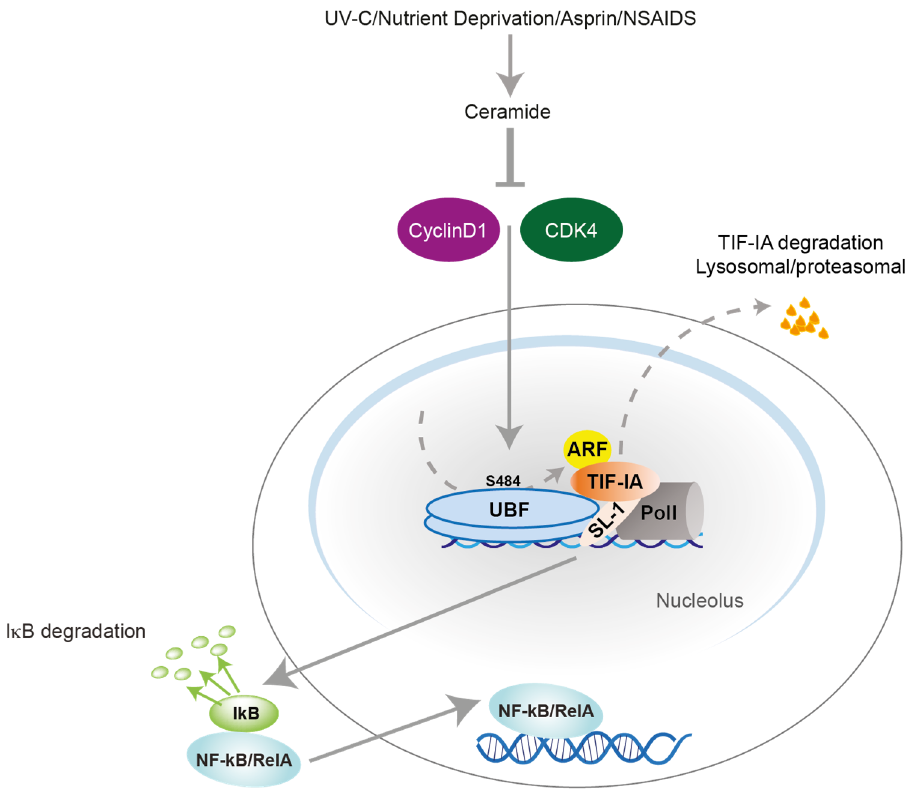
Figure 3. The TIF ‐ IA ‐ NF ‐κ B nucleolar stress response pathway. When cells are exposed to specific stimuli, a cascade of events is triggered that leads to degradation of transcription initiation factor IA(TIF ‐ IA) in a manner dependent on the second messenger ceramide, inhibition of cyclin dependent kinase 4 (CDK4) (depicted by T shaped line), recruitment of the nucleolar protein p14ARF (ARF) and the RNA polymerase I (PolI) complex component, upstream binding factor (UBF). Specifically, serine (s) 484 of this protein. This TIF ‐ IA degradation results in degradation of I κ B α , which allows NF ‐ kB to translocate to the nucleus and regulate expression of target genes that control cellular processes such as apoptosis, proliferation, differentiation and senescence. Solid arrows depicts pathway to NF ‐κ B nuclear translocation. Dashed arrows depict TIF ‐ IA degradation pathway. NSAIDs: non ‐ steroidal anti ‐ inflammatory drugs.